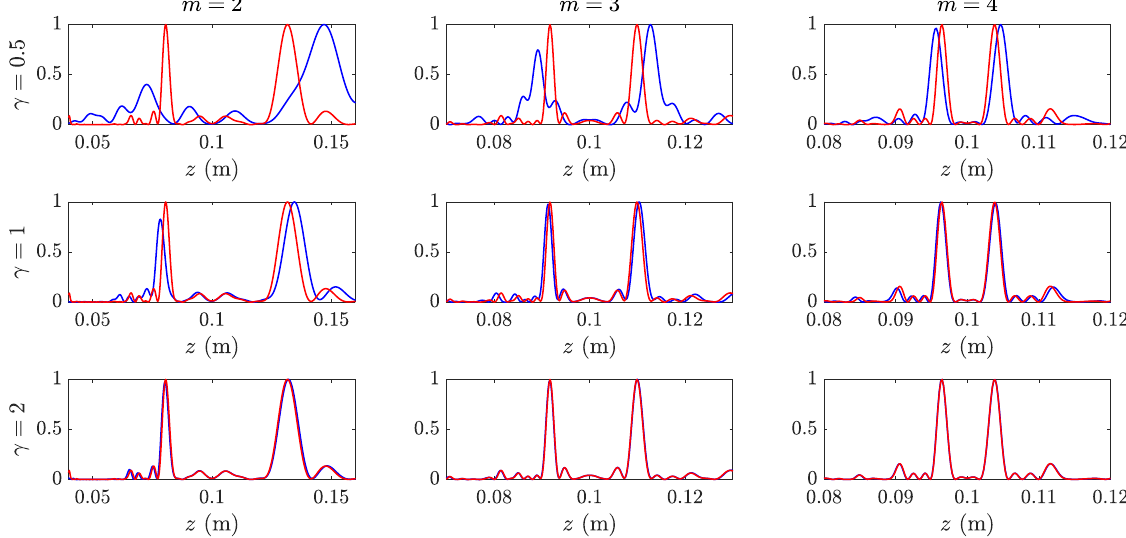
Figure 4. Focusing profiles (blue lines) against axial distance for different values of γ (rows) and m (columns), compared to their ideal counterparts ( γ >> 1) in